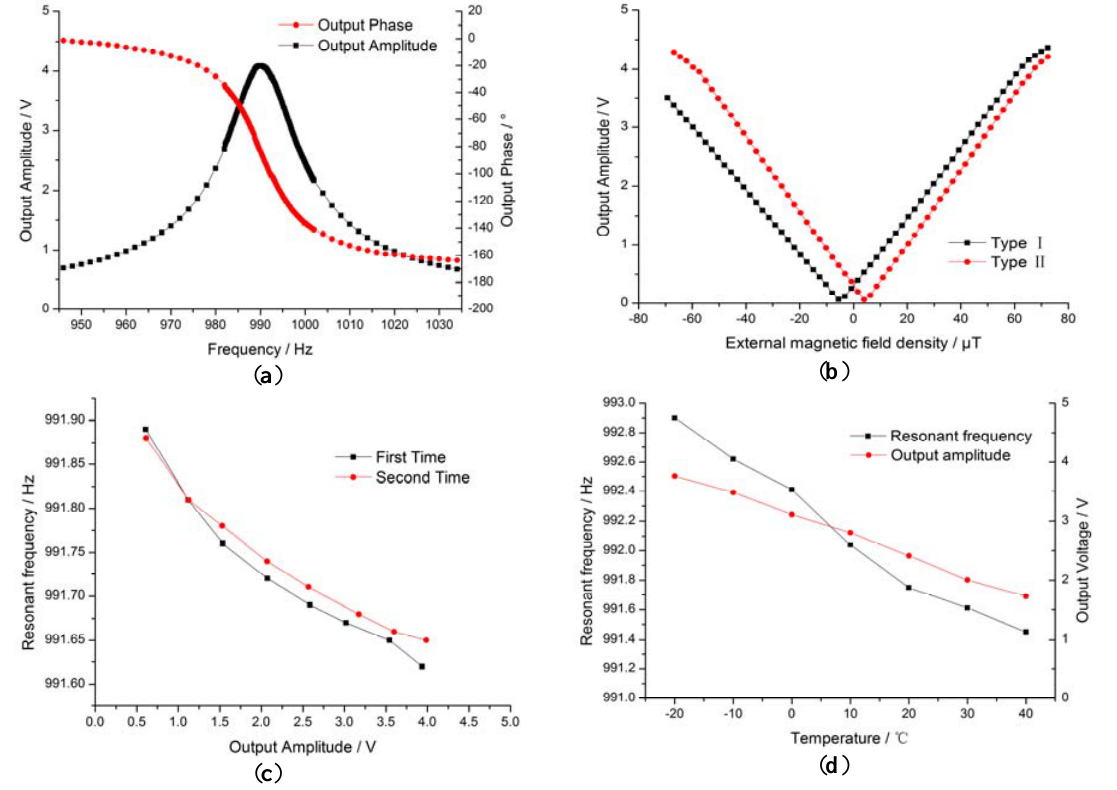
Figure 6. Features of the open-loop prototype. ( a ) Bode diagram of open-loop prototype; ( b ) sensitivity of the open-loop prototype; ( c ) vibration amplitude drift of the resonance frequency; ( d ) temperature drift of the resonance frequency and amplitude.